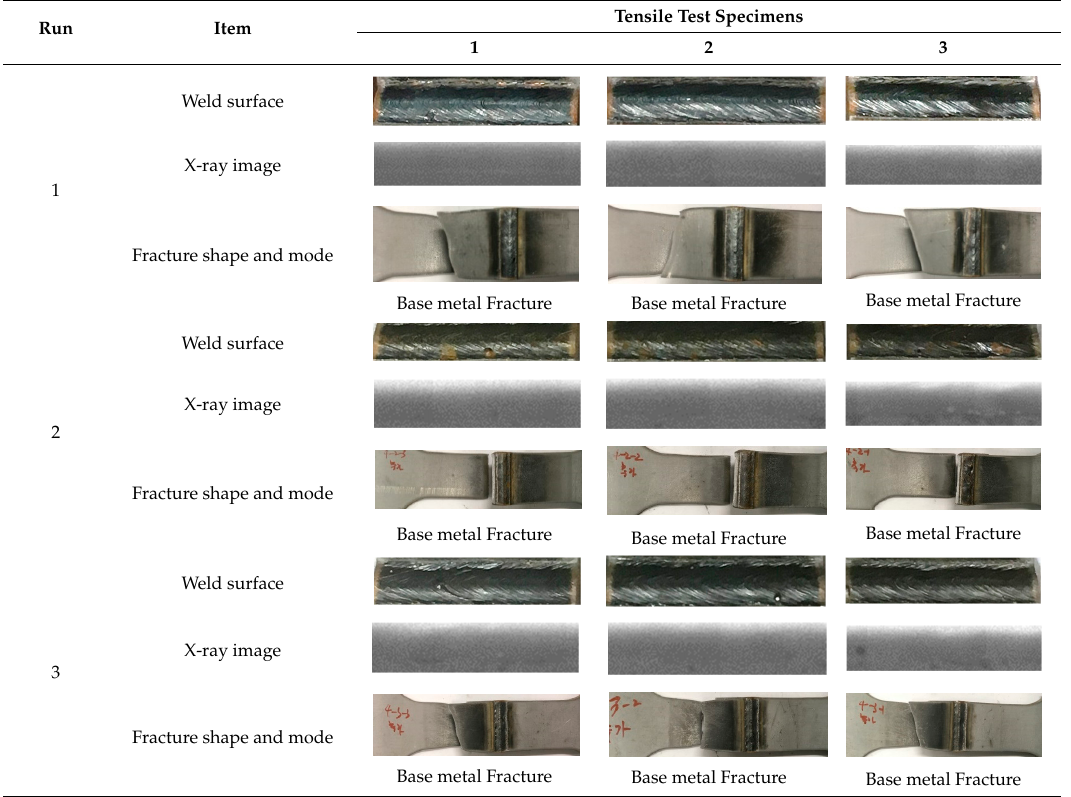
Table 6. Weld bead surface and fracture shape of each test specimen (gap: 0.5 mm).